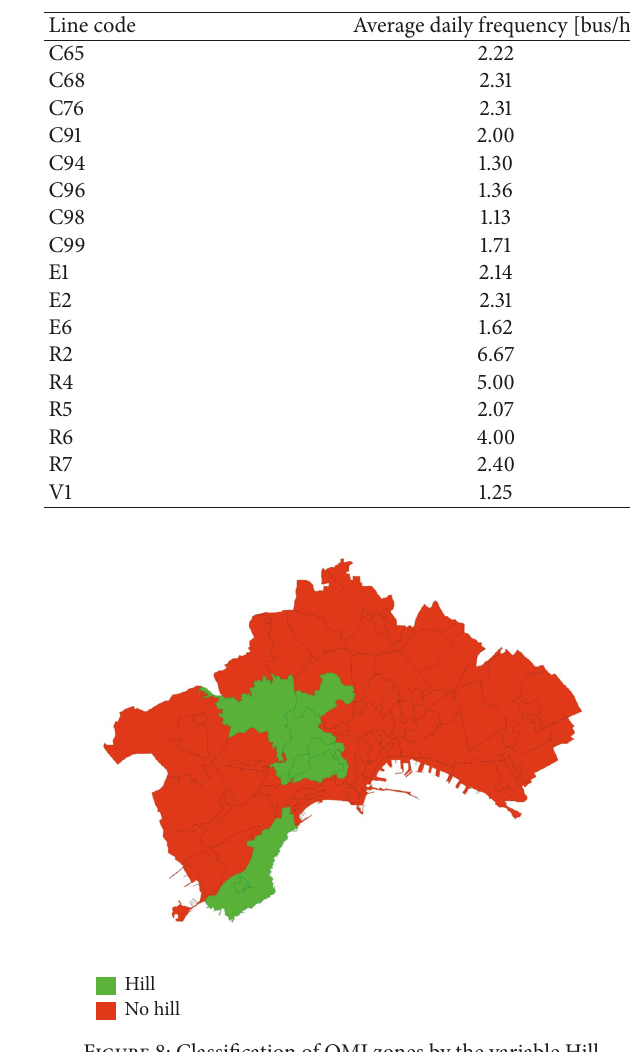
Figure 8: Classification of OMI zones by the variable Hill.